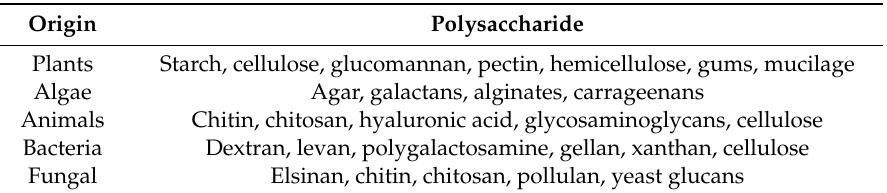
Table 1. List of natural polysaccharides classified according to their